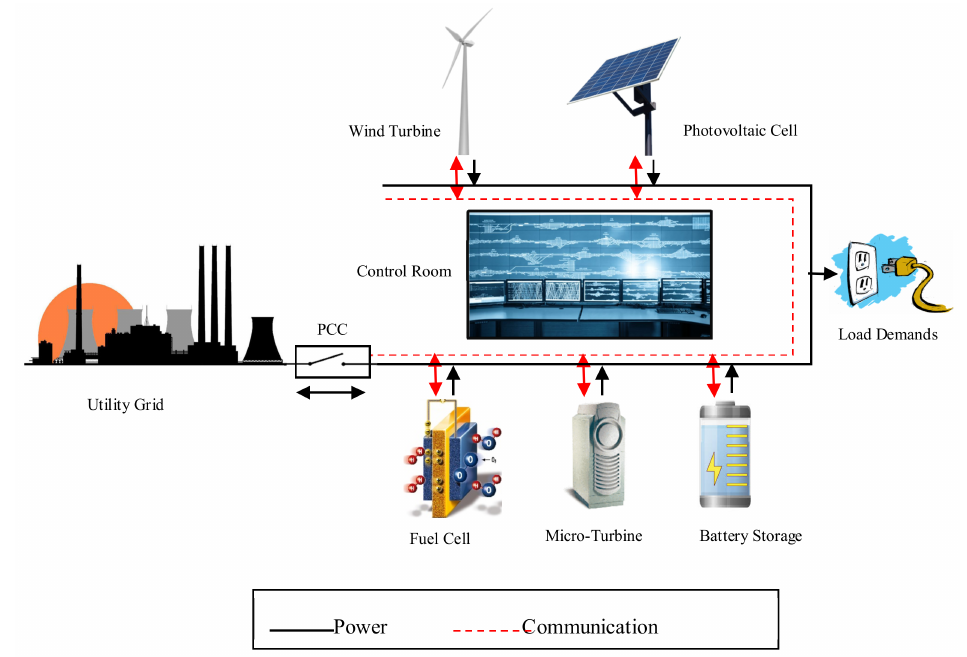
Figure 4. A typical low-voltage microgrid